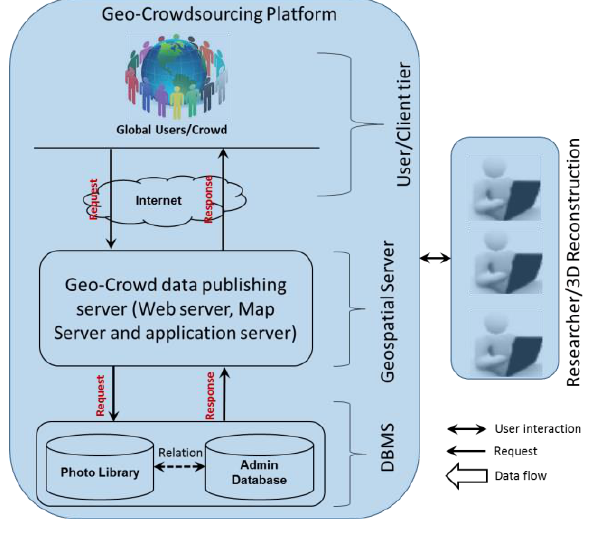
Figure 1. General system